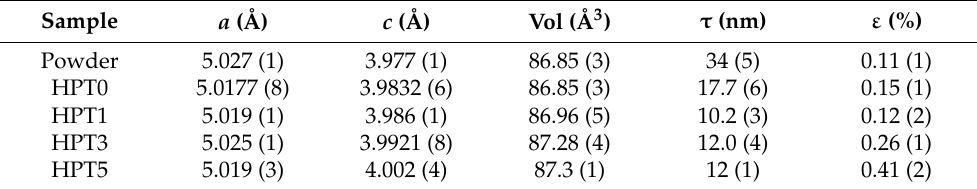
Table 1. Results of Rietveld refinements of the patterns displayed in Figure 1. a and c are the lattice parameters of the LaNi 5 unit cell (space group P6/mmm). Vol is the unit cell volume, τ is the crystallite size and ε is the microstrain. Error on the last significant digit is indicated in parentheses.